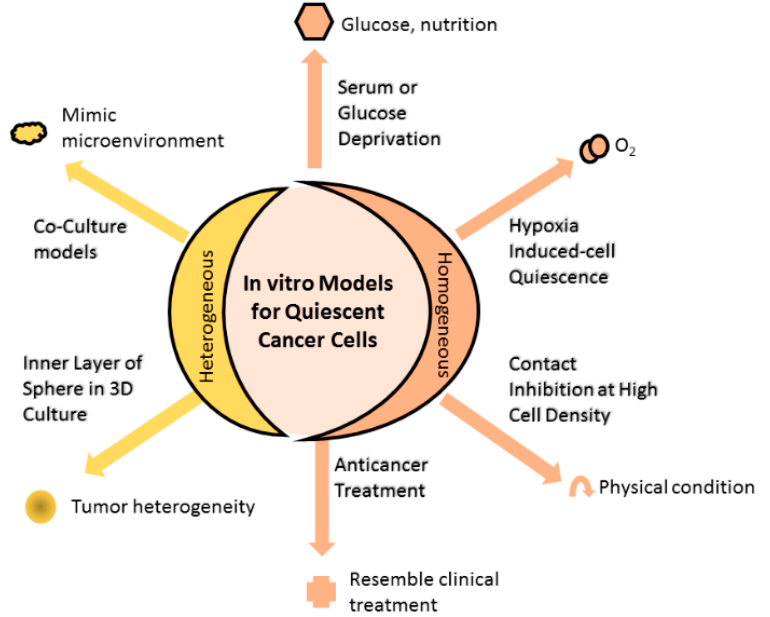
Figure 1. In vitro models for quiescent cancer cells (QCCs). Changing the physical condition of cell culture by allowing cultured cells to grow at high cell density until reaching contact inhibition or depriving essential substances (such as serum, glucose, or oxygen) of the culture, or administering anticancer treatment into cell culture that homogenously induces cells into quiescence. Alternatively, cell culture can heterogeneously comprise quiescent and proliferating cells using the 3D culture method. The inner and outer layers of 3D spheres are mainly composed of quiescent and proliferating cells, respectively, resembling the tumor heterogeneity observed in the clinical setting. Other means to achieve heterogeneous cell composition are coculturing different cell populations that mimic the microenvironment in which actual tumor cells grow, while anticancer treatment induces a portion of cells to quiescence, as found in the clinical setting. Table 1. Overview of the model and method of quiescent cancer cell